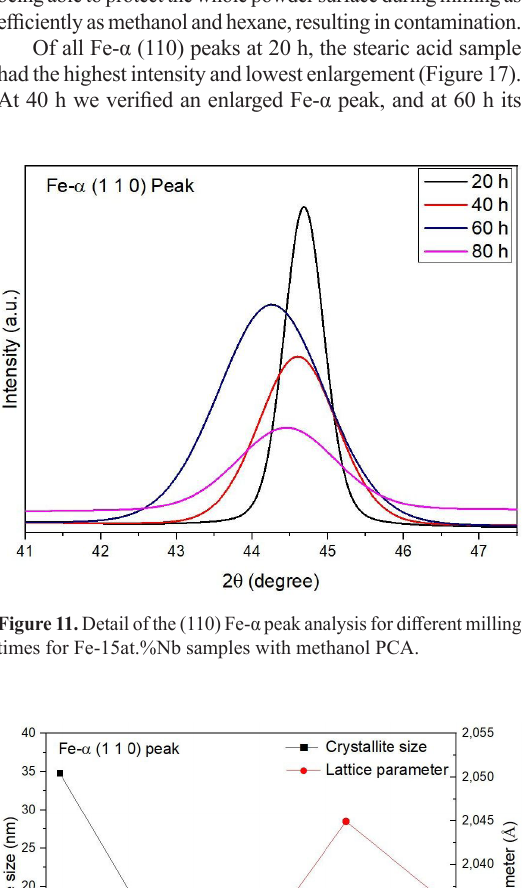
Figure 8. Detail of the (110) Fe-α peak analysis for different milling times for Fe-15at.%Nb samples without PCA (reference).